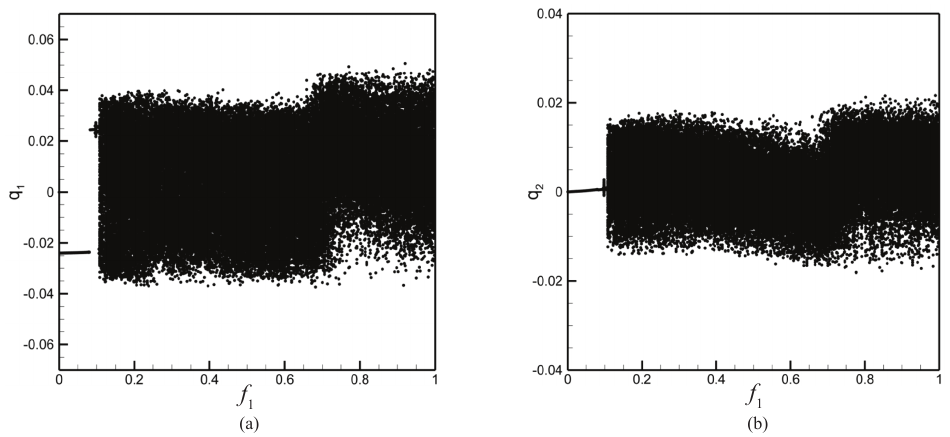
Fig. 12. Bifurcation diagrams of Poincaré points for increasing forcing amplitude on the system with c = 1 . 8 ,α = 1 . 5 and β = 0 . 3 .